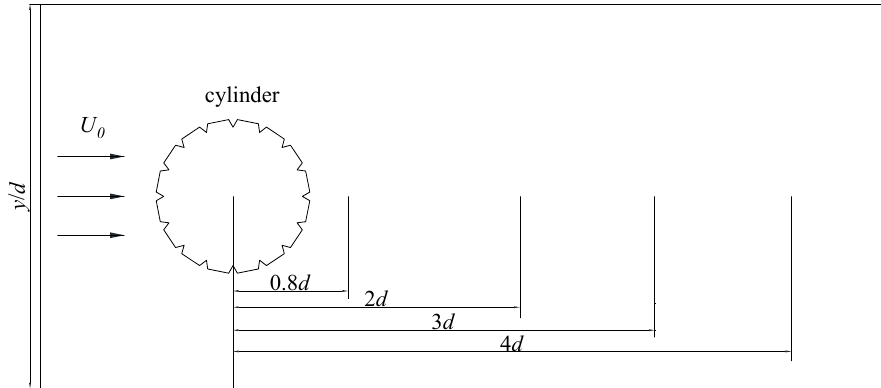
Figure 3. Schematic diagram of wake velocity extraction location.